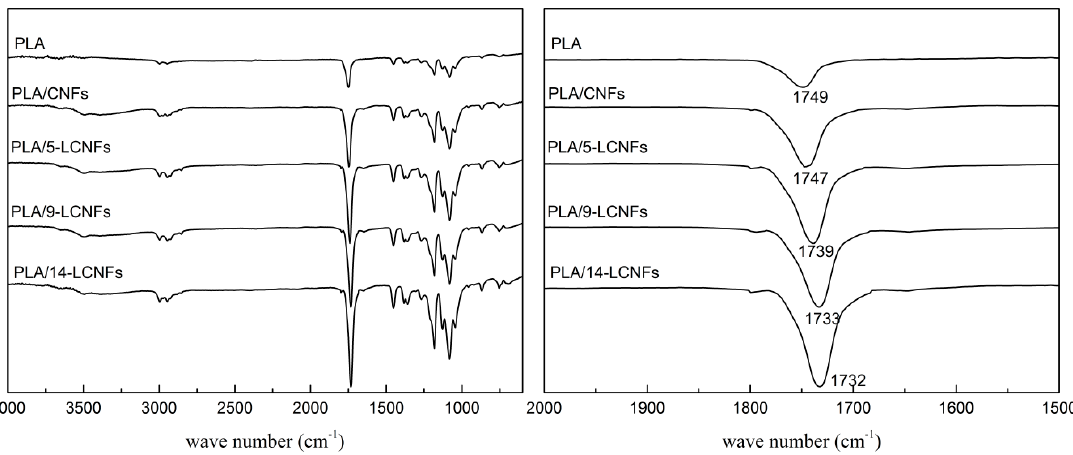
Figure 2. FTIR spectra of PLA, the PLA/CNFs composite, and PLA/LCNFs composites with different lignin